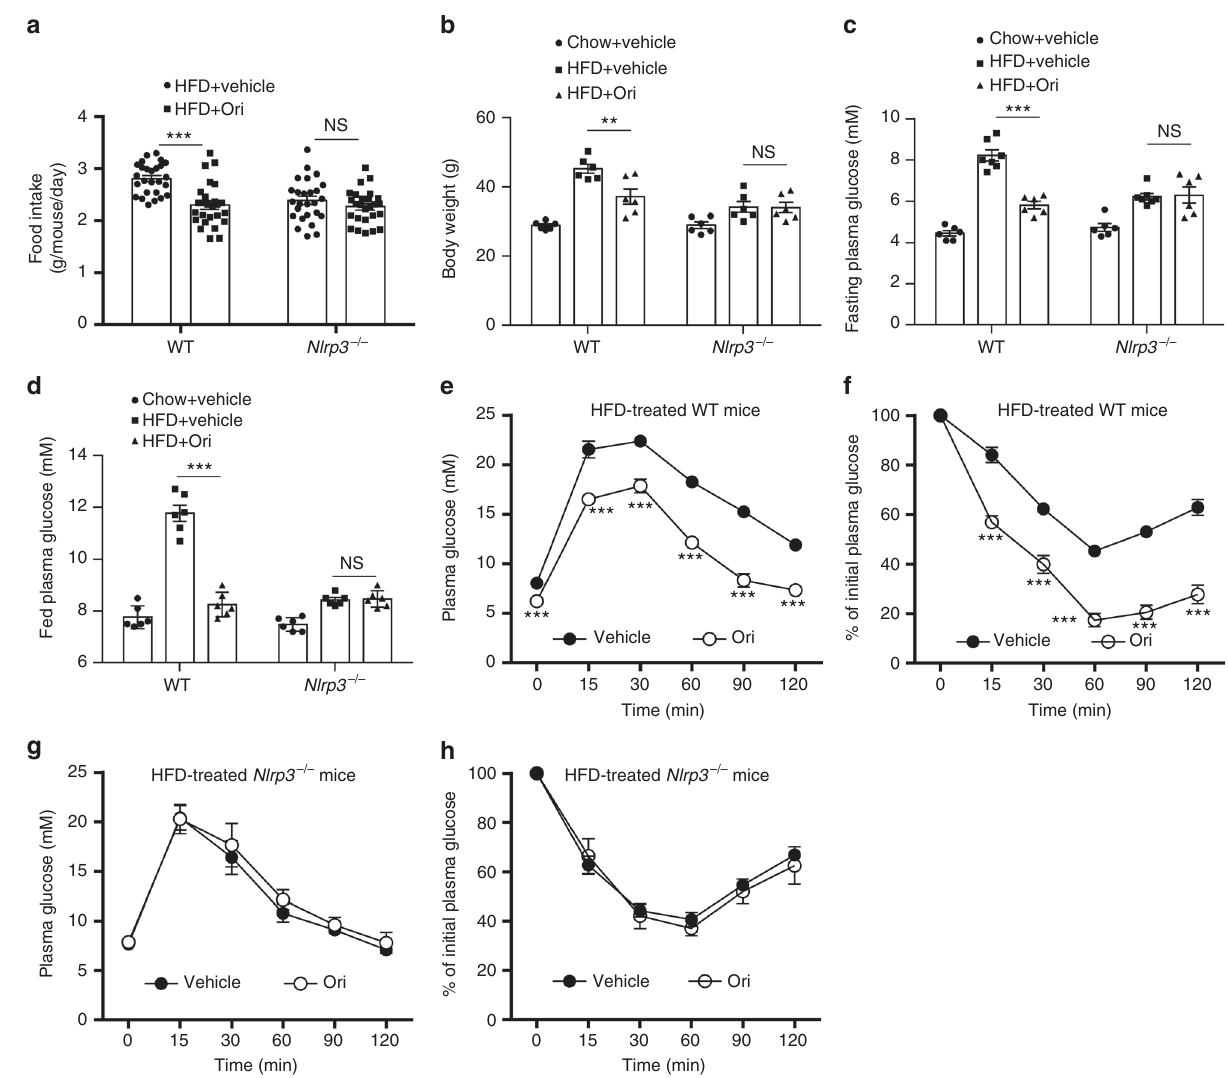
Fig. 7 Treatment of metabolic disorders in HFD-induced diabetic mice with Ori. a , b Food intake and body weights of 16-week HFD-fed WT or Nlrp3 -/- mice after 6-week vehicle or Ori treatment. n = 26 per group. c , d Fasting ( c ) or fed ( d ) blood glucose levels of 16-week HFD-fed WT or Nlrp3 -/- mice treated with vehicle or Ori for 6 weeks. n = 6 per group. e – h GTT ( e , g ) or ITT ( f , h ) of 16-week HFD-fed WT or Nlrp3 -/- mice treated with vehicle or Ori for 6 weeks. Data are expressed as mean and s.e.m and are representative of two independent experiments. Statistical differences were calculated by